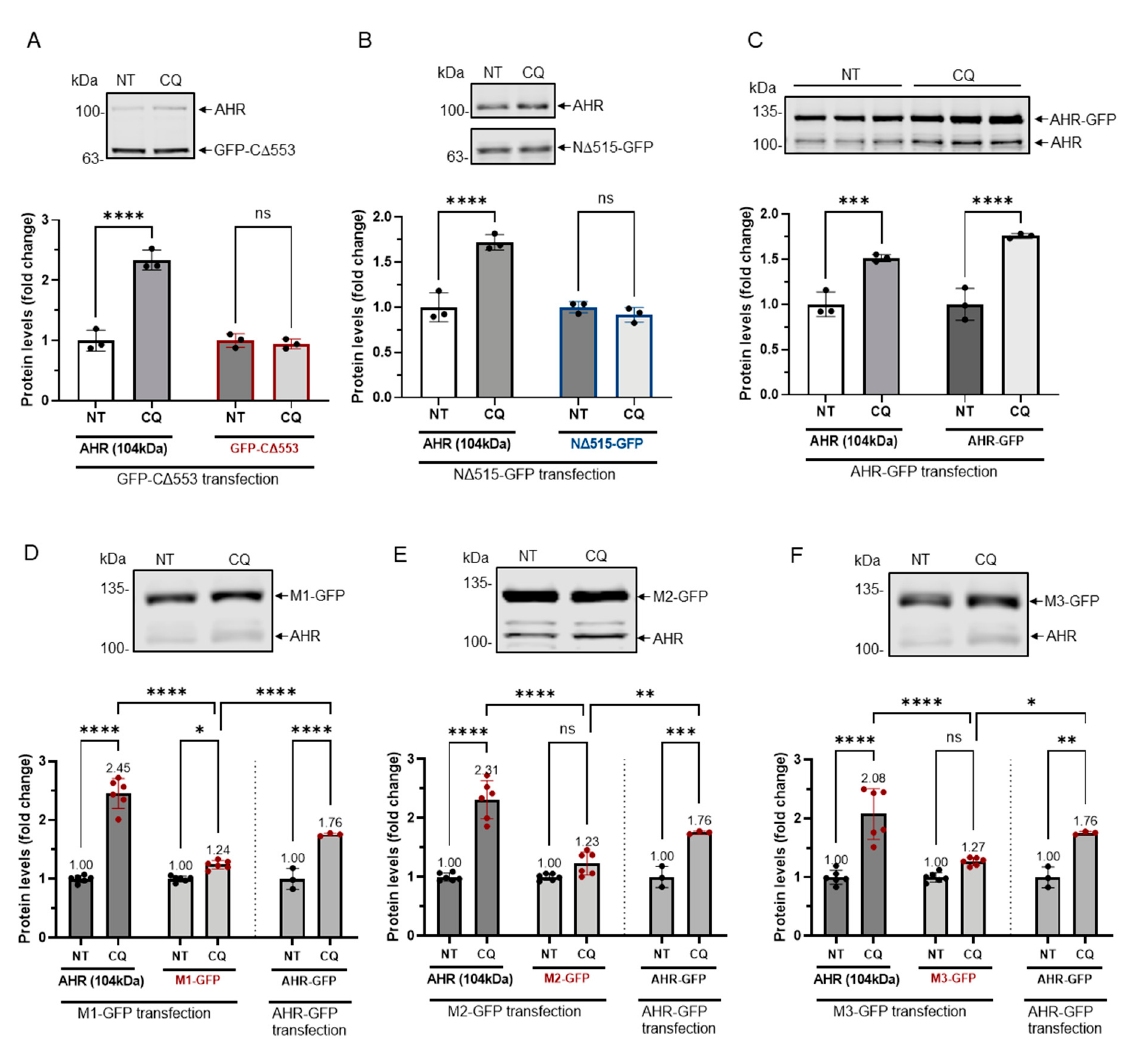
Figure 6. GFP fusions of two truncated AHR and three mutants were less sensitive to lysosomal degradation. HeLa cells that were transiently transfected (for 54 h) with the plasmid expressing GFP-C ∆ 553 ( A ), N ∆ 515-GFP ( B ) or full length AHR-GFP ( C ) were treated with either no treatment (NT) or 40 µ M CQ for 6 h. Only AHR-GFP showed similar increase as the endogenous AHR upon TDG treatment. The images are representative of the replicate data (means ± SD, n = 3, *** p < 0.001, **** p < 0.0001, ns represents not significant) in one experiment, and was repeated once with similar results. No treatment group (NT) was arbitrarily set as one for data normalization. One-way ANOVA with Sidak multiple comparisons test was performed to determine statistical significance. HeLa cells that were transiently transfected (for 54 h) with the plasmid expressing M1-GFP ( D ), M2-GFP ( E ) or M3-GFP ( F ) showed a significant lower increase of 1.2- to 1.3-fold when compared to 2.0- to 2.5-fold increase of endogenous AHR upon treatment of 40 μ M CQ for 6 h. These increases were significantly less when compared to AHR-GFP (data from 6C). The images in (D-F) are representative of the replicate data (means ± SD, n = 6, * p < 0.05, ** p < 0.01, *** p < 0.001, **** p < 0.0001). No treatment groups (NT) were arbitrarily set as one for data normalization. Two experiments of n = 3 each were performed so that error bars are present on the NT groups. The dotted lines separate the AHR-GFP transfection data that are presented in 6C for easy reference. One-way ANOVA with Sidak multiple comparisons test was performed to determine statistical significance. For A to F, each Western lane contained 30 µ g of whole-cell lysate. Data were normalized by total protein stain. N ∆ 515-GFP (6B) was detected by the GFP antibody since this construct could not be detected by SA210 AHR antibody while all other GFP fusions of AHR and derivatives were detected by SA210 AHR